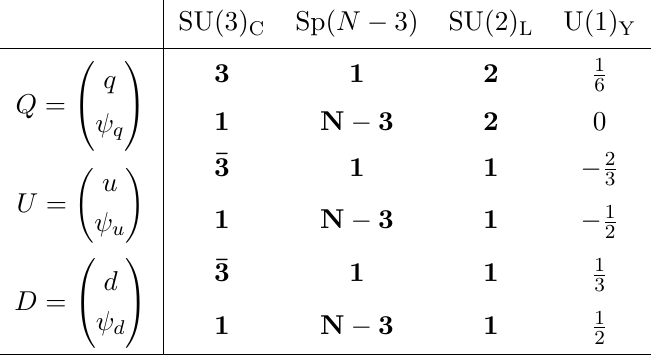
, ψ q ) is an electroweak u d and U(1) GC ⊂ SU( N ) GC Y 0